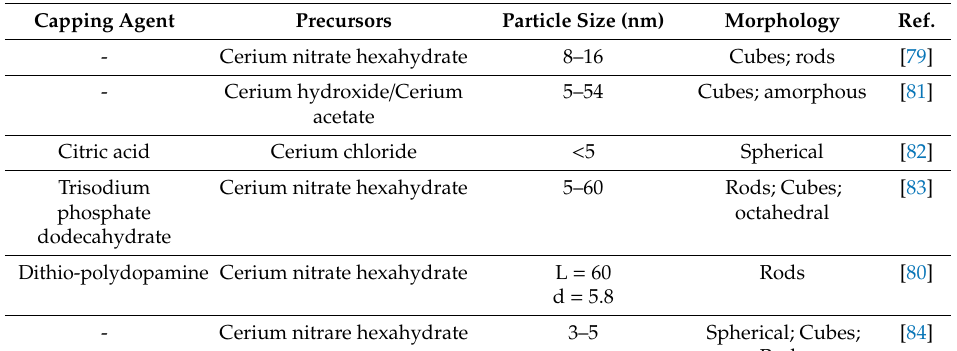
Table 3. Table showing the synthesis of cerium oxide nanoparticles using the hydrothermal method. Capping